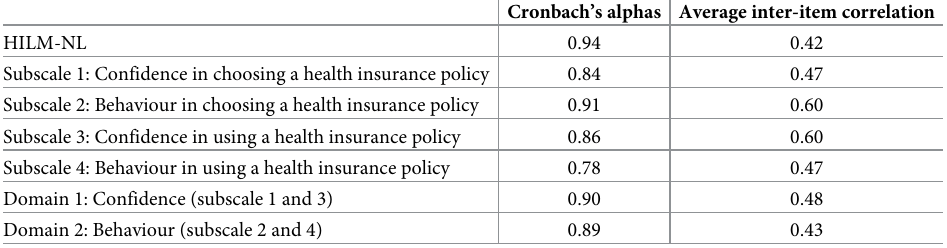
Table 3. Cronbach’s alphas and average inter-item correlation of the HILM-NL and its subscales and domains in February 2020 (n = 781).